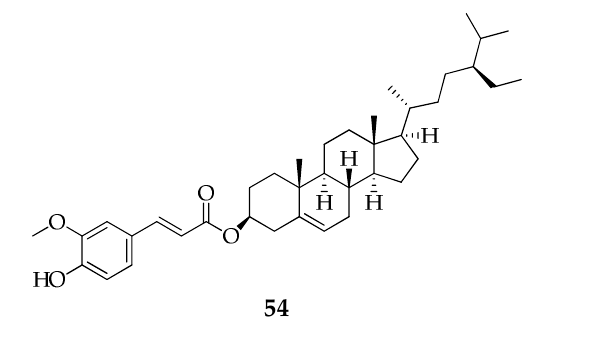
Figure 3. The compounds in different varieties of red rice bran use different isolation methods. ( 24 )